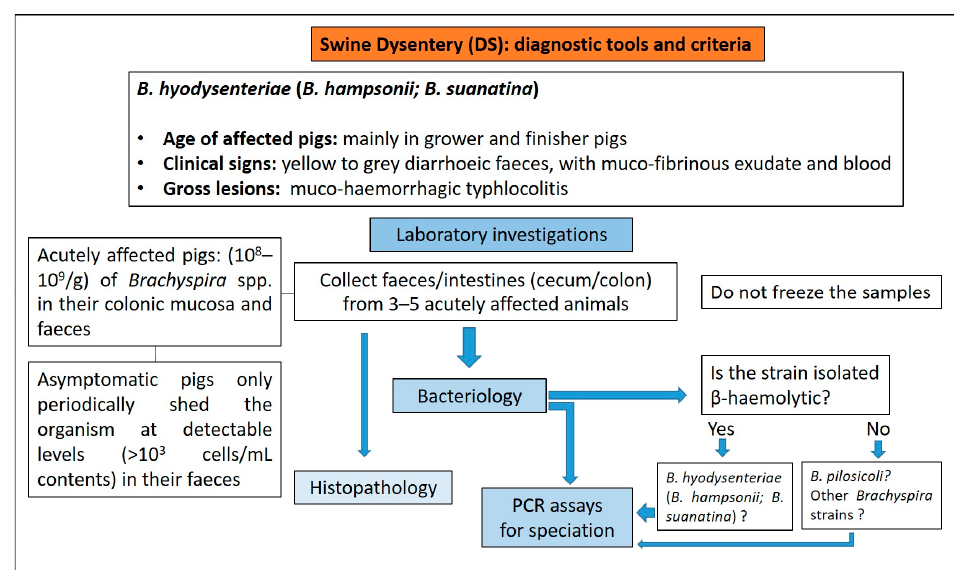
Figure 28 Figure 28. Diagnostic algorithm for the diagnosis of SD in